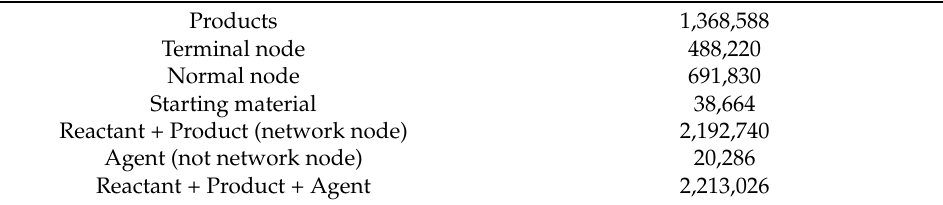
Figure 6. Subgraph of the reaction knowledge graph network. Nodes that begin with “ZINC” are terminal nodes as well as starting materials. Others are normal nodes that could be recognized as either the product of the starting materials, or the reactant for other products. The width of the line represents the number of chemical patents involved in the reaction. The thicker the line, the more patents use the reaction. Table 1. Statistics in the reaction knowledge